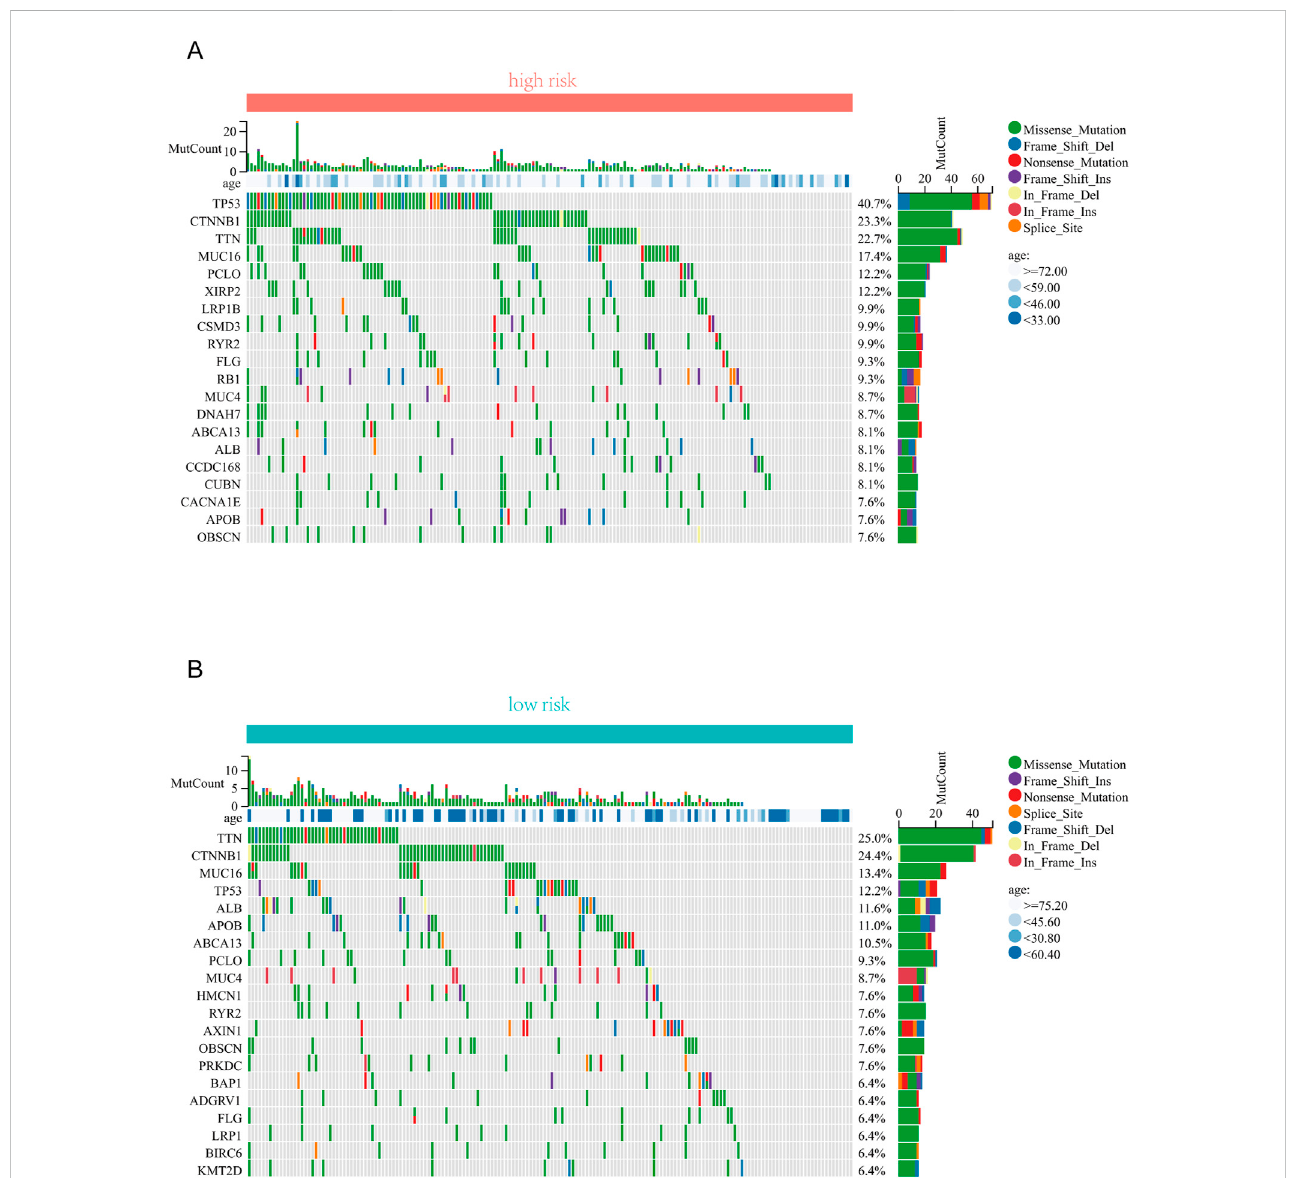
Correlation analysis between risk score and TMB . (A) The top 20 driver genes with the highest alteration in the high-risk group. (B) The top 20 driver genes with the highest alteration in the low-risk group.